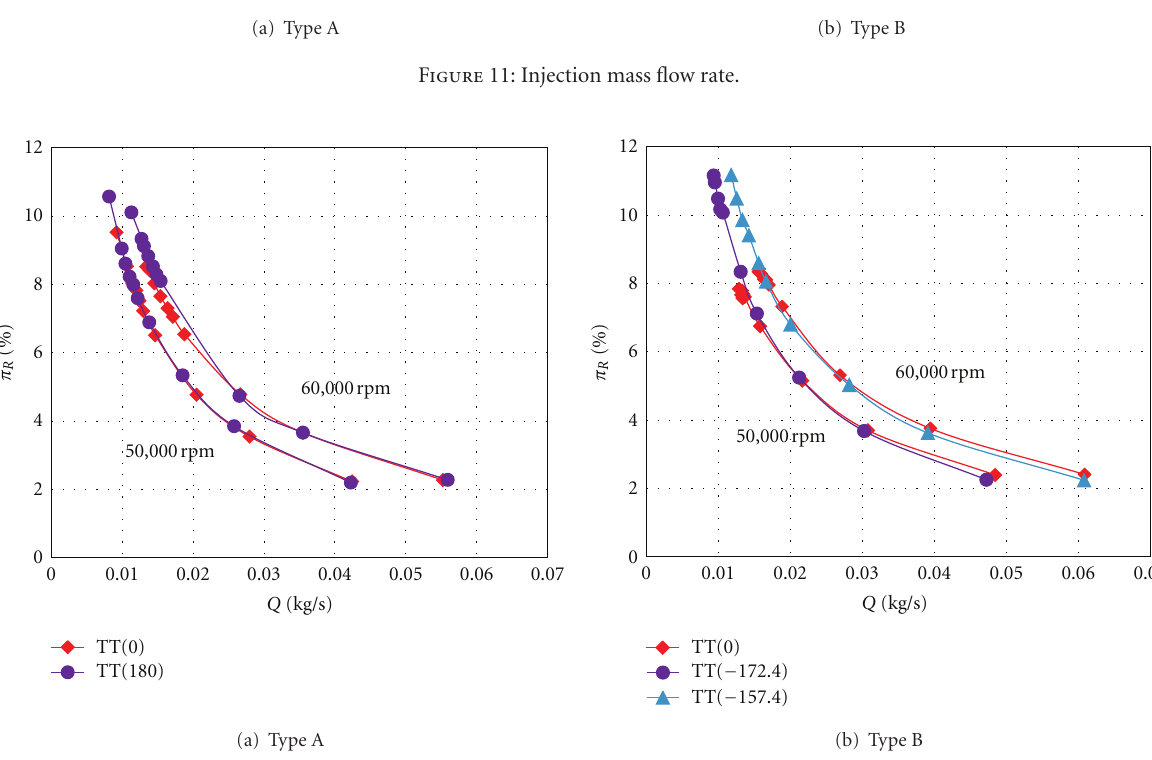
Figure 12: Recirculation